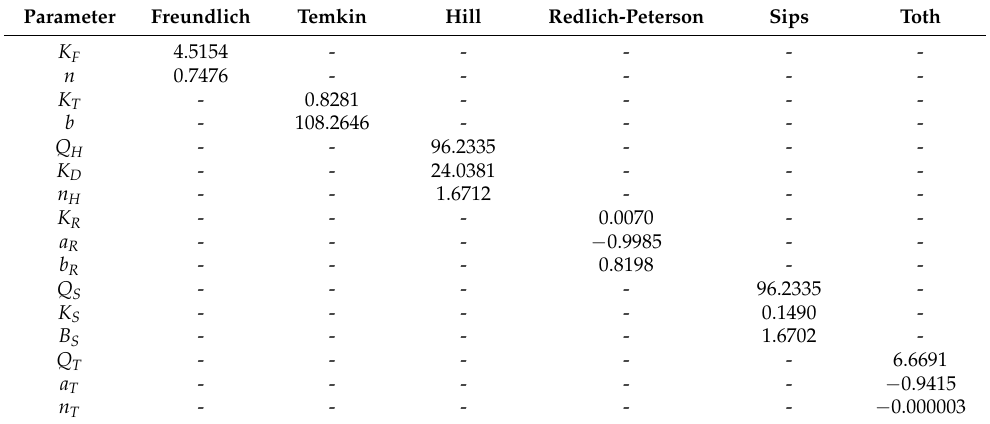
Table 8. Equilibrium isotherm parameters of the biosorption process conducted on SPA 5% biosorbent. Parameter